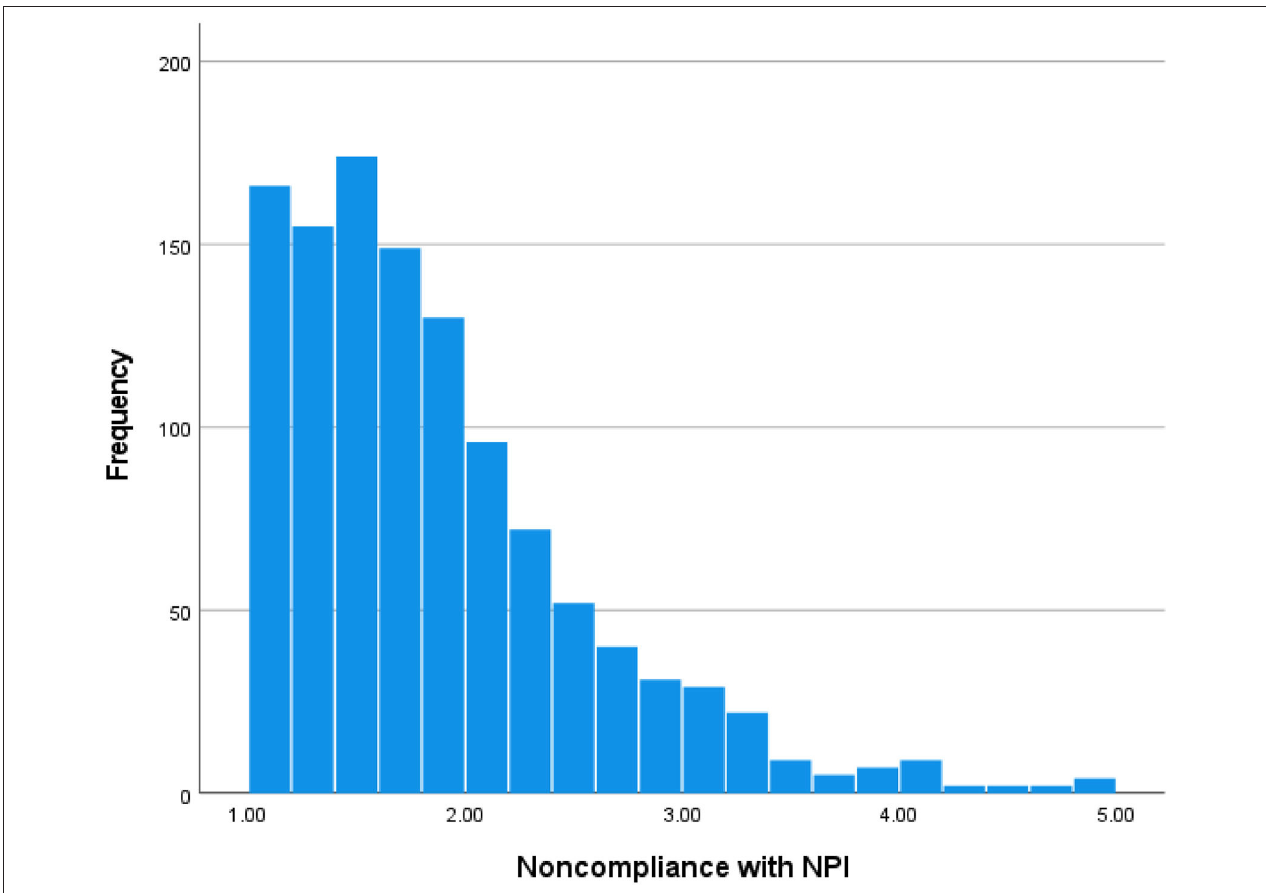
FIGURE 1 | Scores on the global scale of non-compliance with non-pharmaceutical intervention (NPI). Scale ranges from 1 (complete compliance) to 5 (complete non-compliance); scores smaller than 3 indicate a tendency to compliance and scores > 3 indicate a tendency to